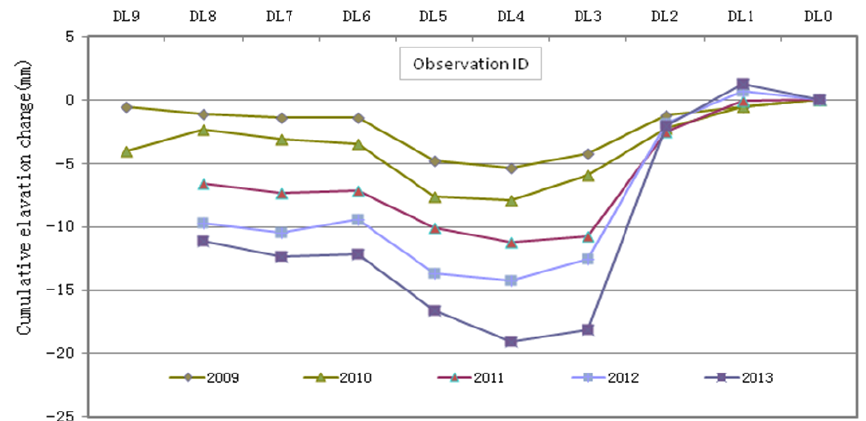
Figure 5. Cumulative elevation changes from 2009 to 2013 at the ten leveling benchmarks established across the fissure at Guangming Village. DL0 is used as reference point. The distance between DL0 and DL9 is approximately 80m.